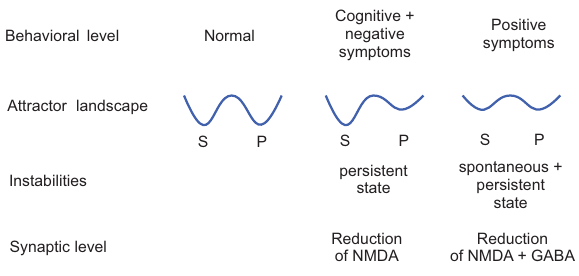
Fig. 4 Summary of the attractor hypothesis of schizophrenic symptoms and simulation results (see text). The fi rst basin (from the left) in each energy landscape is the low fi ring rate spontaneous state (S), and the second basin is the persistent (or continuing) high fi ring rate attractor state (P). The horizontal axis of each landscape is the fi ring rate, increasing to the right. The vertical axis of each landscape is the energy potential. (Modi fi ed from Loh et al. 7